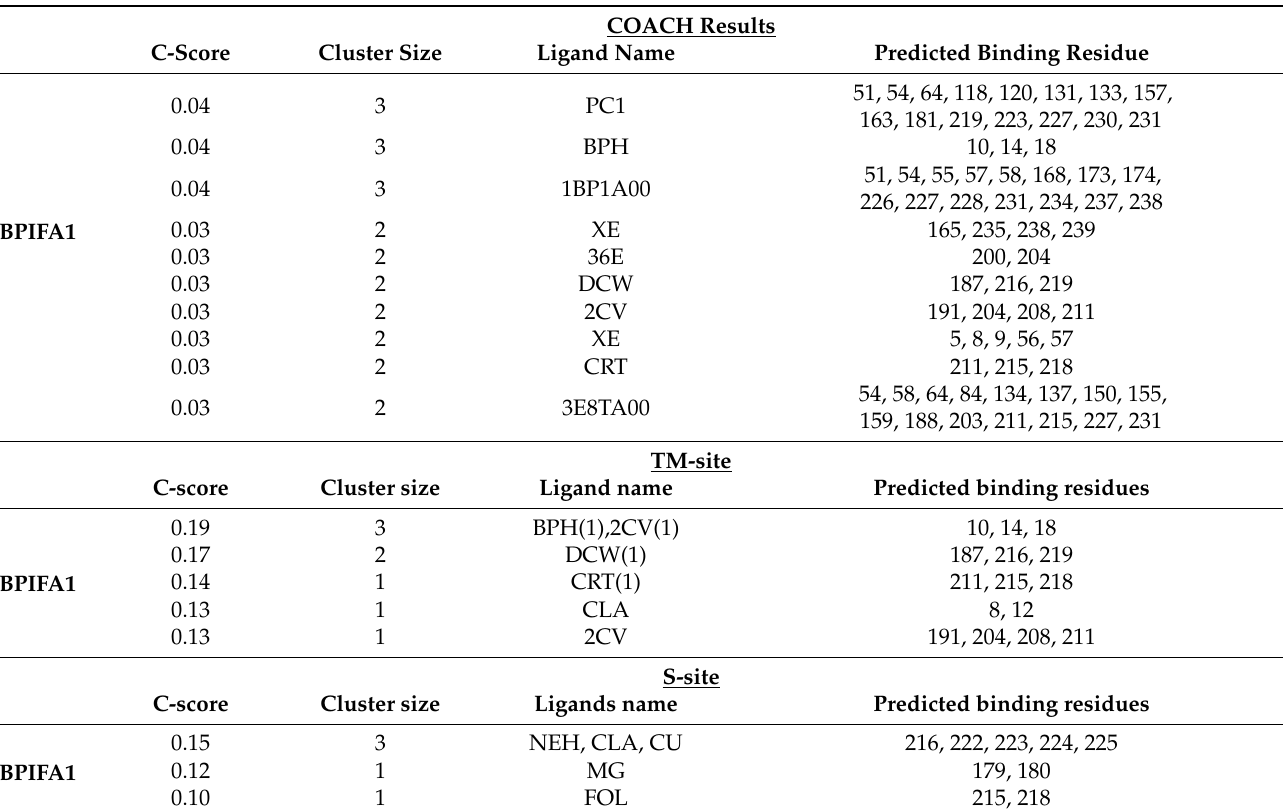
Table 7. Recognition of protein-ligand binding sites of BPIFA1 using complementary comparisons of binding-specific substructures and sequence profile